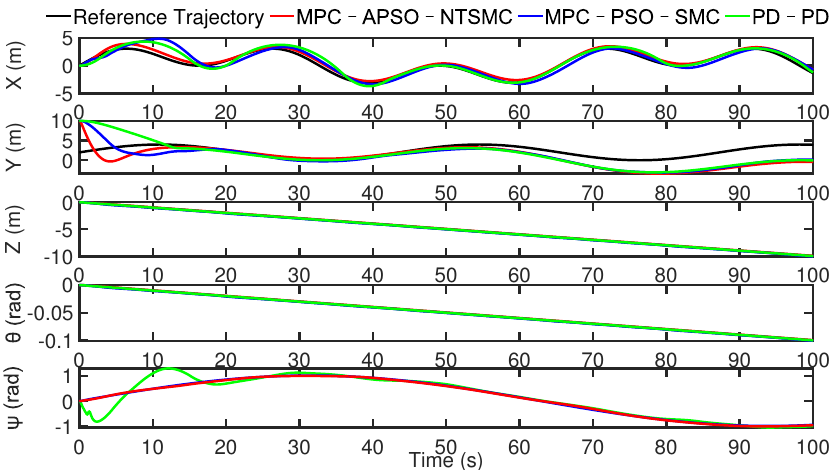
Figure 26. Position tracking performance for the tracking task with random disturbance for Case 2.